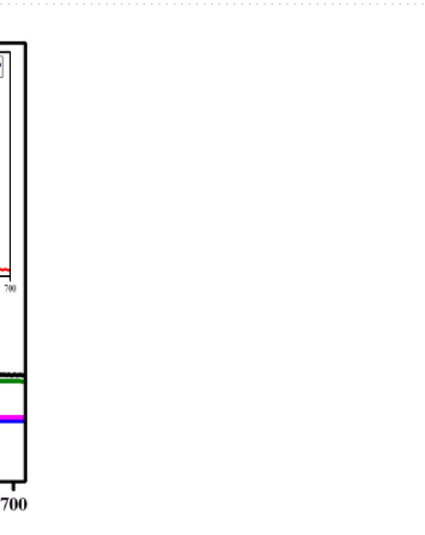
Figure 2. ( a ) FT-IR spectra of CNCs, TPP, Zn-TPP and CNCs/Zn-TPP nanocomposite, ( b ) structure of TPP (I) and Zn-TPP (II).